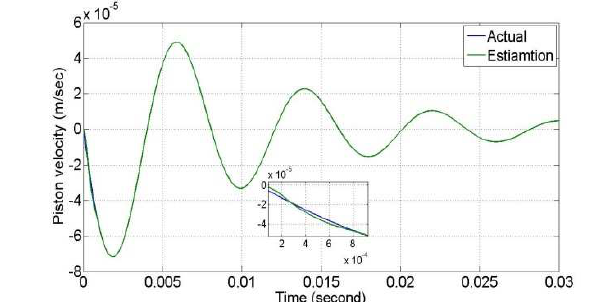
estimation (cid:157) ¡